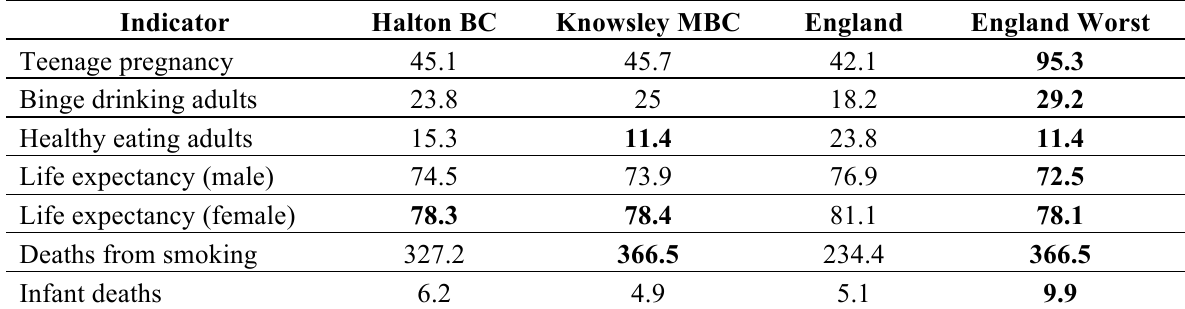
Table 5. Community health and social well-being indicators.